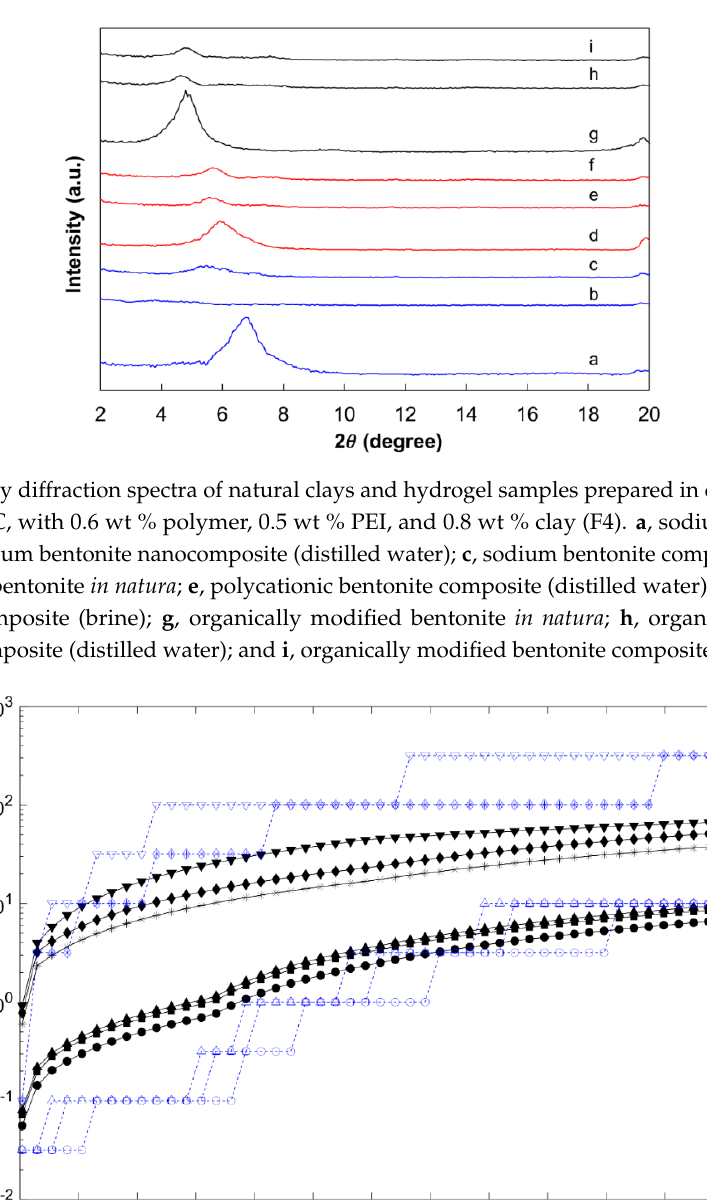
Figure 6. Complex modulus ( ─ ) and gel strength (- -) versus time for samples prepared in distilled or field water at 85 °C, with 0.6 wt % polymer, 0.5 wt % PEI, and 0.8 wt % clay of different types (F4).